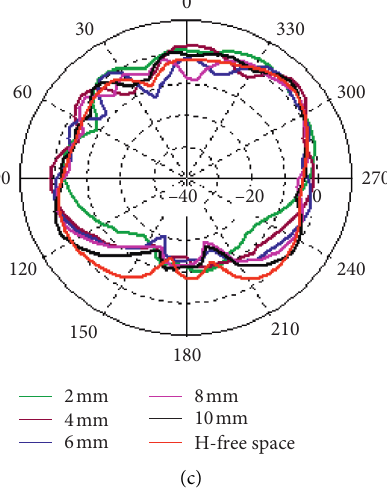
Figure 12: Polyester on-body (a) Return loss at different distances, (b) E-plane radiation patterns and (c) H-plane radiation patterns.